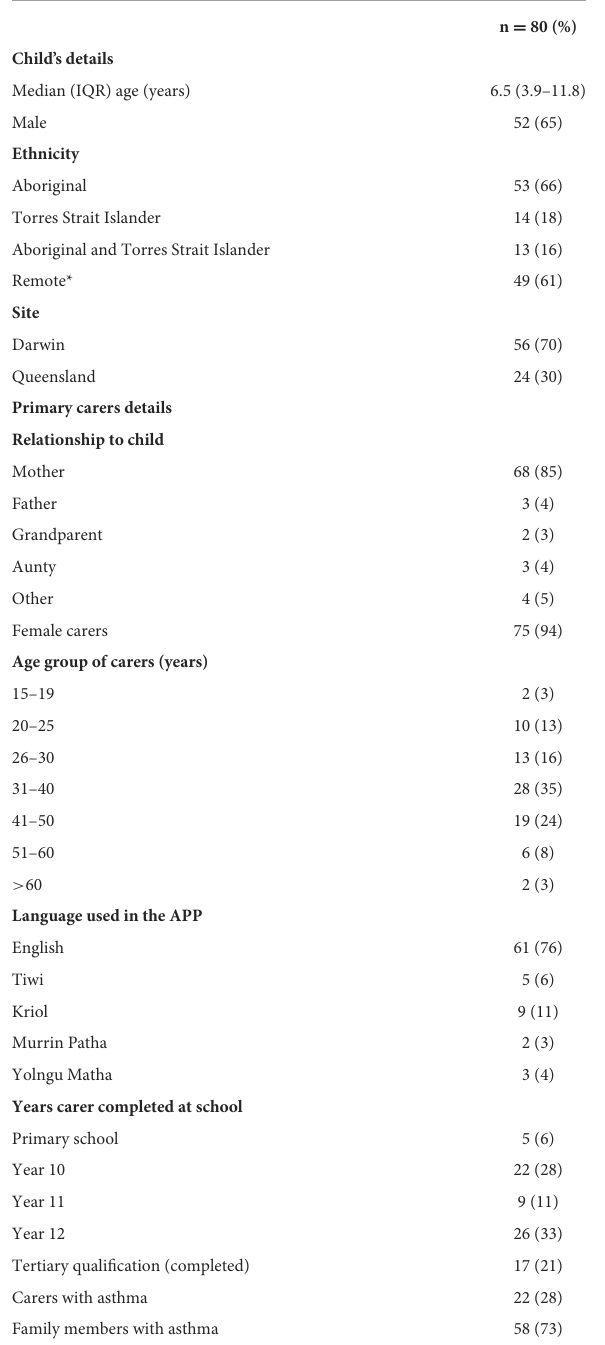
TABLE 1 Baseline demographics of child and